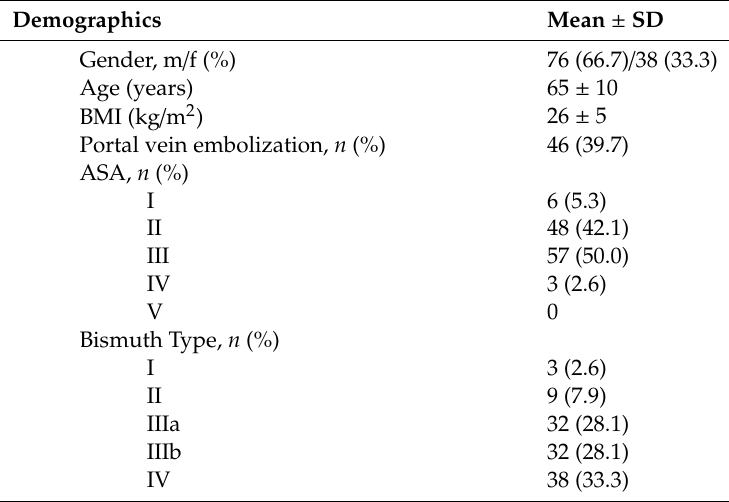
Table 1. Clinical characteristics ( n =